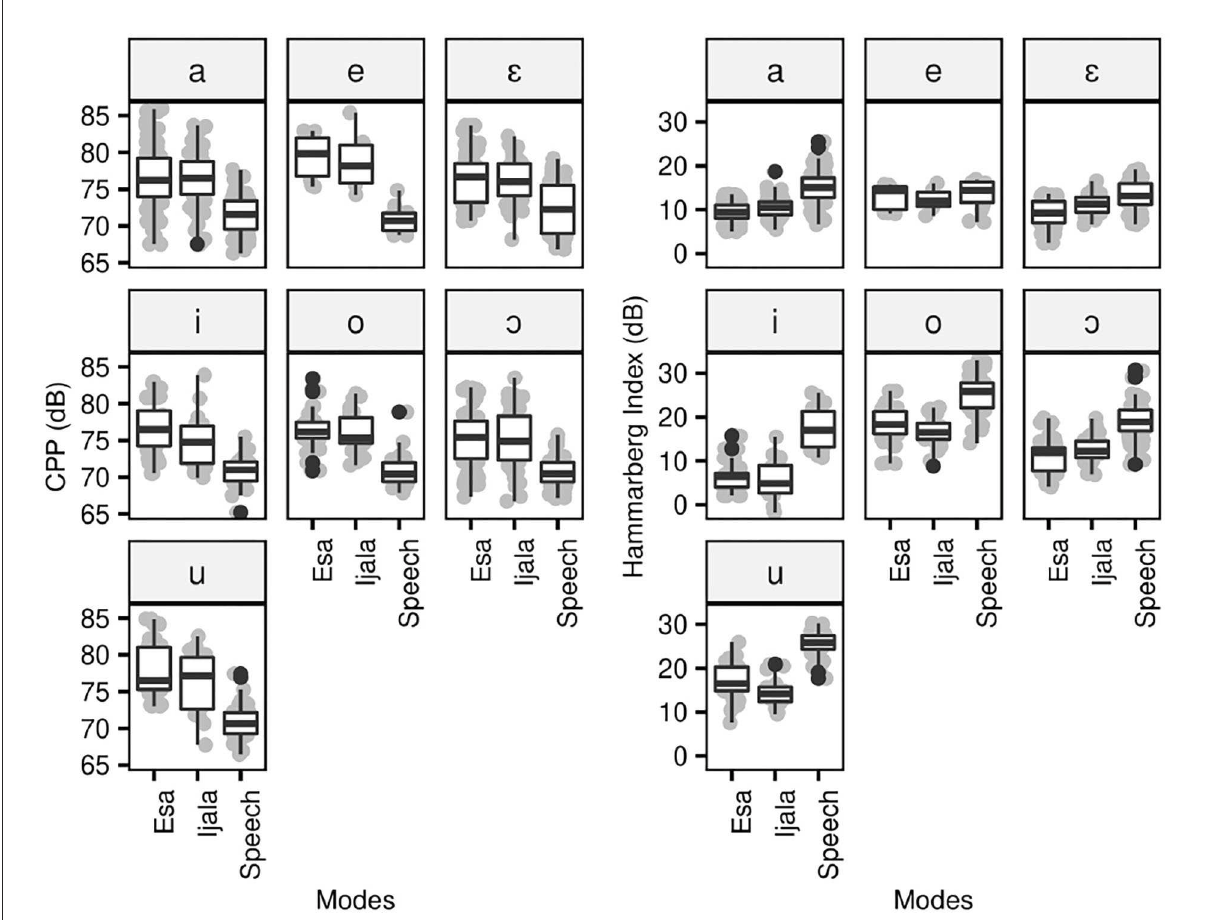
FIGURE7 CPP(dB) and Hammarberg index(dB) of oral vowels in poetic and speech